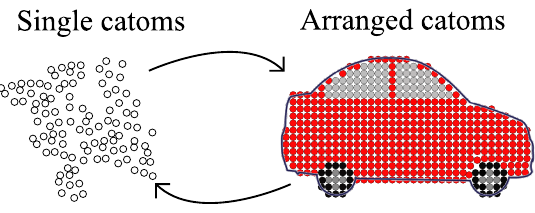
Figure 1. Illustration of programmable matter used for car prototyping